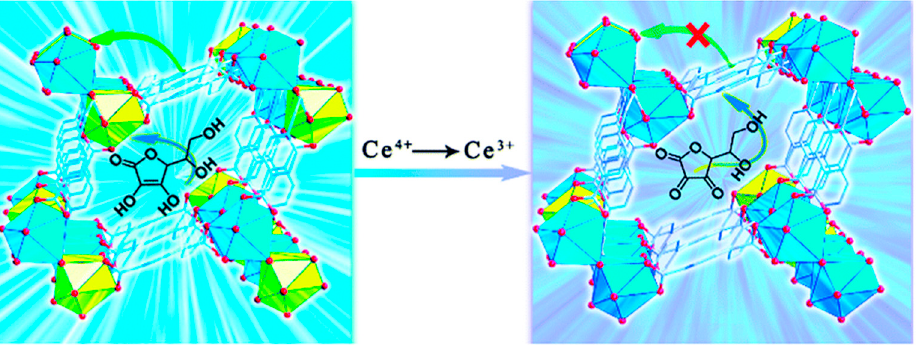
Figure 8. Schematic demonstration of a Ce-MOF, ZJU-136-Ce, for the luminescent detection of AA. Reprinted with permission from [132]. Copyright (2017) Royal Society of Chemistry. Reprinted with permission from [132]. Copyright (2017) Royal Society of